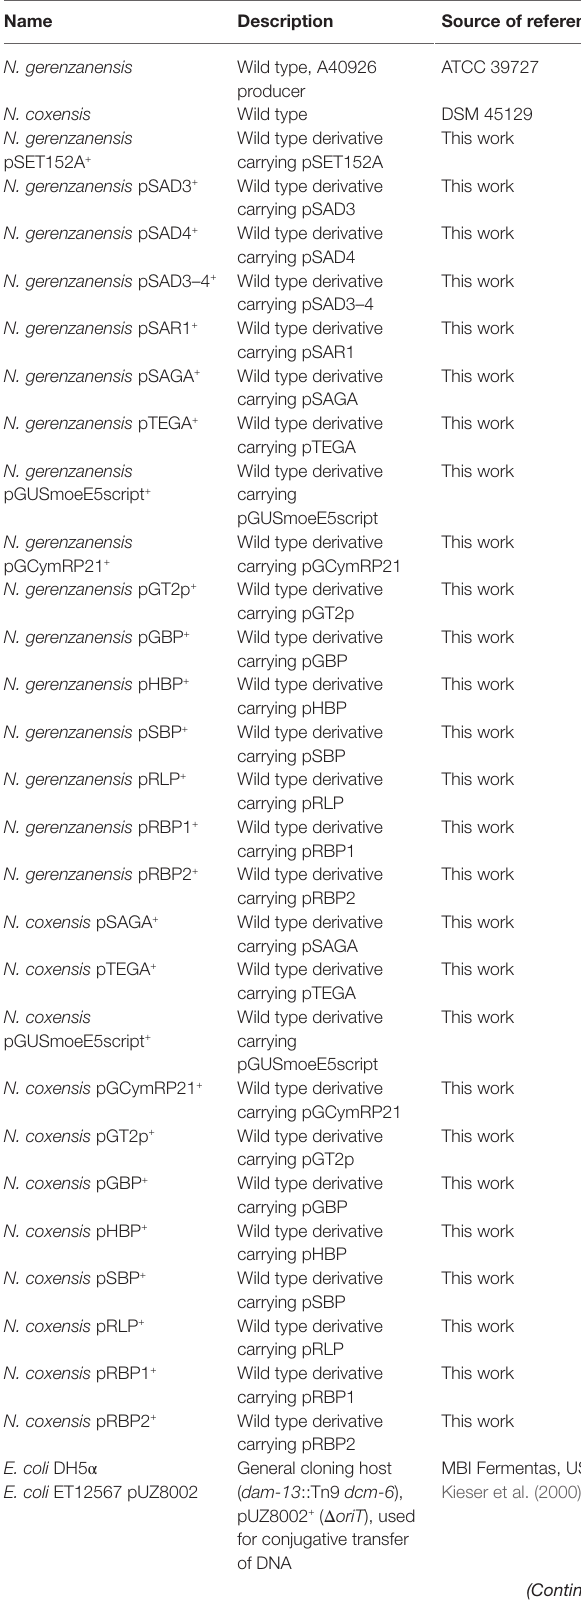
TABLE 1 | Bacterial strains and plasmids used in this